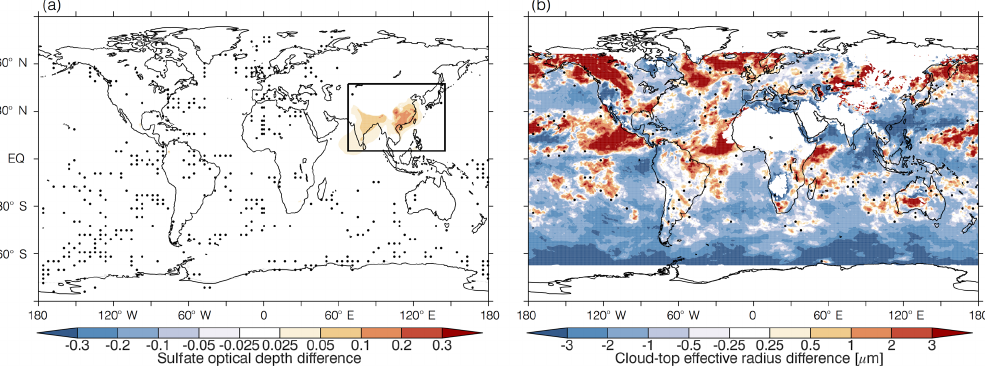
Figure 2. Ensemble mean, (1998–2012) vs. (1979–1993), difference in (a) sulfate optical depth (with the black box indicating the emission region), and (b) cloud-top effective radius. Dots indicate where the response is not significant at the 10% level, as calculated using a two- tailed Student’s t test. Figure 6c shows the agreement of individual ensemble members on the sign of the anomaly in cloud-top effective radius shown in panel (b)